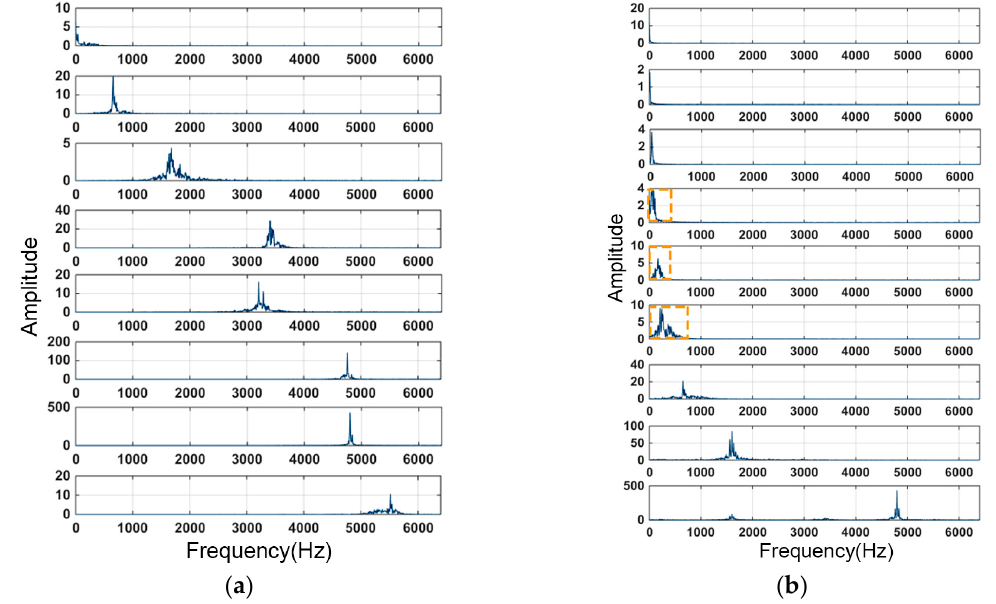
Figure 3. Comparison of frequency–domain signals of ( a ) the VMD method and ( b ) the EMD method